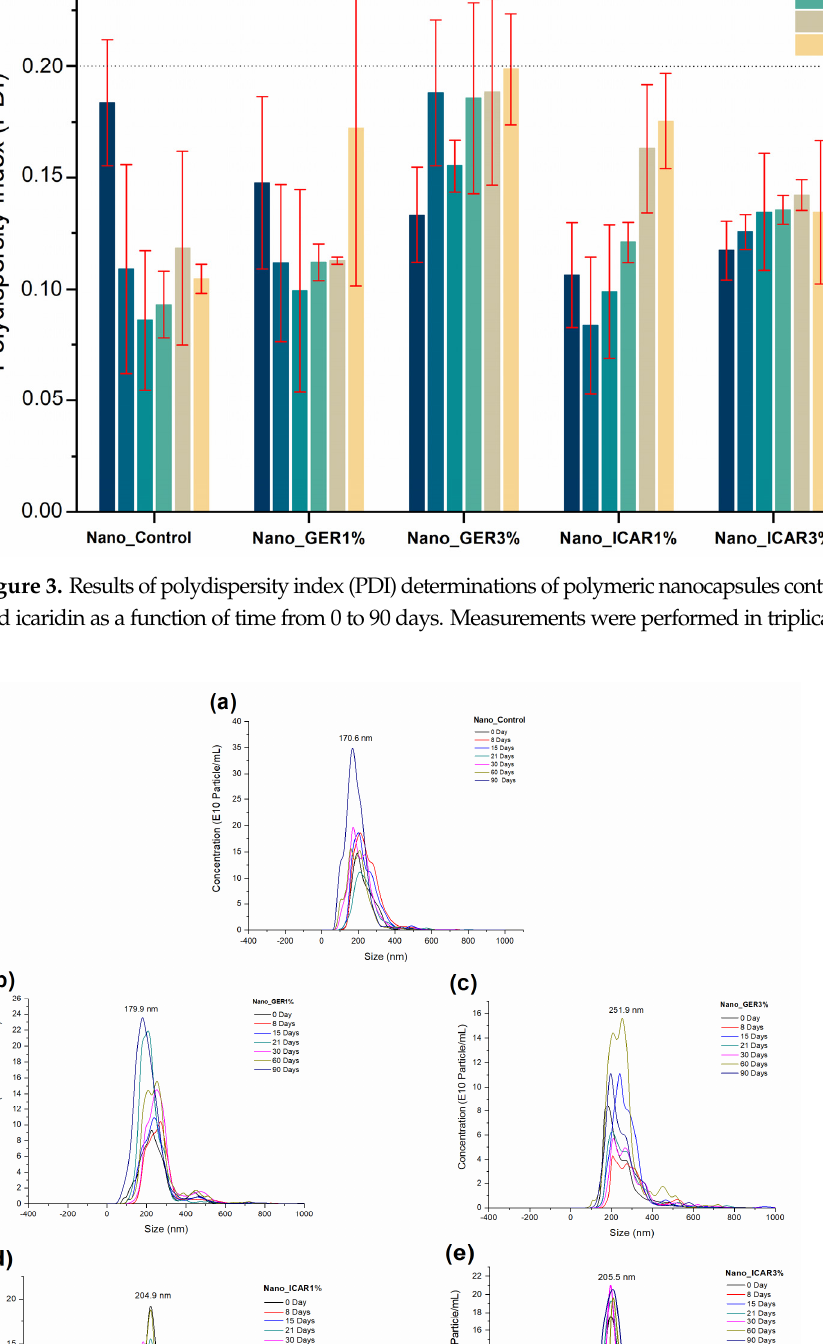
Table 1. Correlation coefficient (R 2 ) for the different mathematical models used for the release ki- netics of nanocapsules containing the active substances geraniol and icaridin.